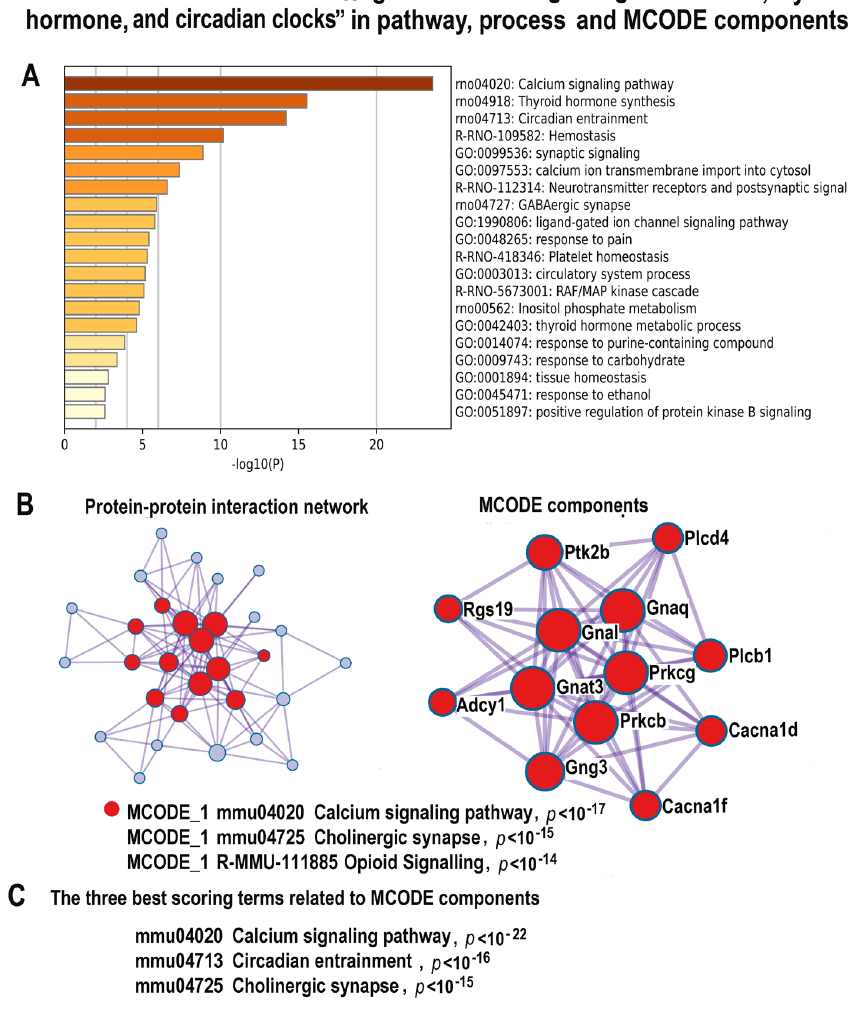
Figure 8. The enrichment of NLI − inhibited genes related to the cluster “Signaling via calcium, thyroid and circadian clocks” in gene pathway and process and in molecular complexes. ( A )—Bar graph of enriched terms related to gene pathways and processes across the gene cluster related to signaling via calcium, thyroid hormone, and circadian clocks. The statistical significance of enrichment is shown in X -axis ( − log10( p )). ( B )—Protein–protein interaction network and MCODE components (or densely connected network components) were identified in the gene list. The network and MCODE components were constructed on the base of physical interactions taken from the String server (physical score > 0.4). The coding by color square reflects the MCODE components. The coding by color circles indicates the results of the MCODE component pathway and process enrichment analysis. ( C )—The three best-scoring terms related to MCODE components.